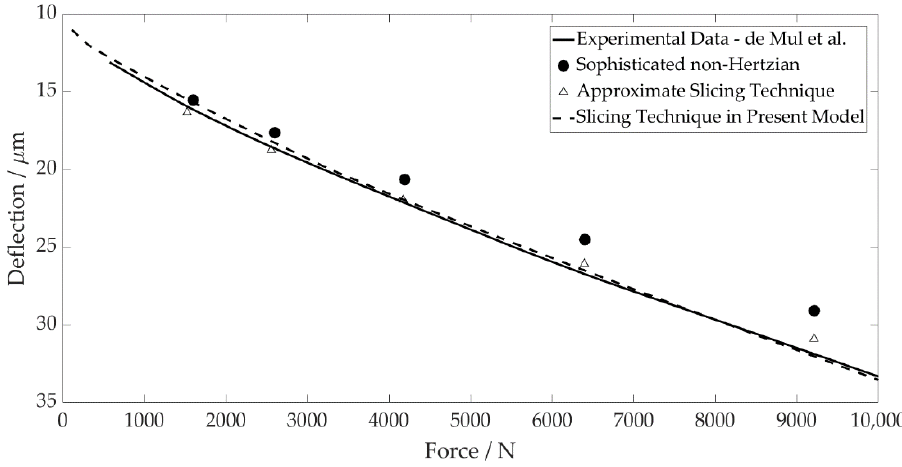
Figure 5. Contact Level Validation.